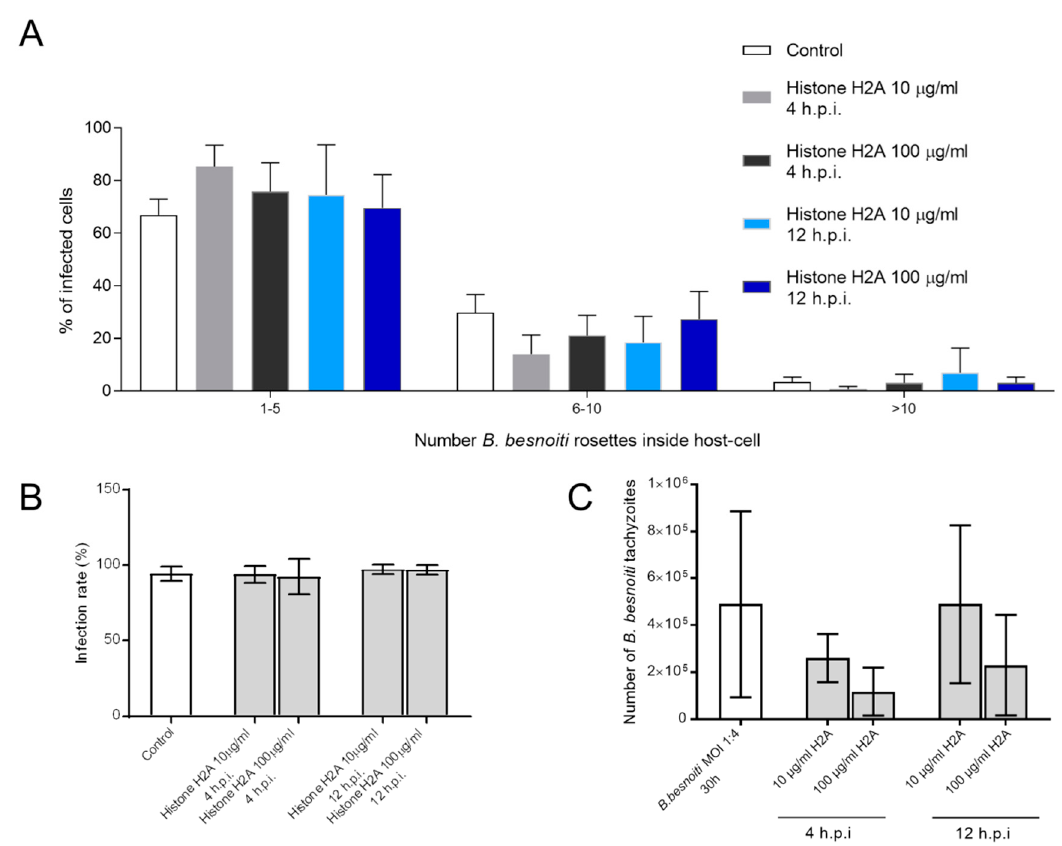
Figure 5. Histone 2A (H2A) did not affect the number of intracellular B. besnoiti rosettes. B. besnoiti -infected BUVEC (three different isolates, N = 3) were treated with H2A (10 or 100 μ g/mL) at 4 and 12 h.p.i. At 24 h.p.i. cell layers were analyzed by randomly taking five microscopic images using phase contrast microscopy. The total number of B. besnoiti rosettes per host cell was determined and the percentage of host cells carrying different numbers of PV was estimated and sub-grouped in different categories (with 1–5, 6–10 and >10 rosettes/cell, respectively; ( A )). Furthermore,